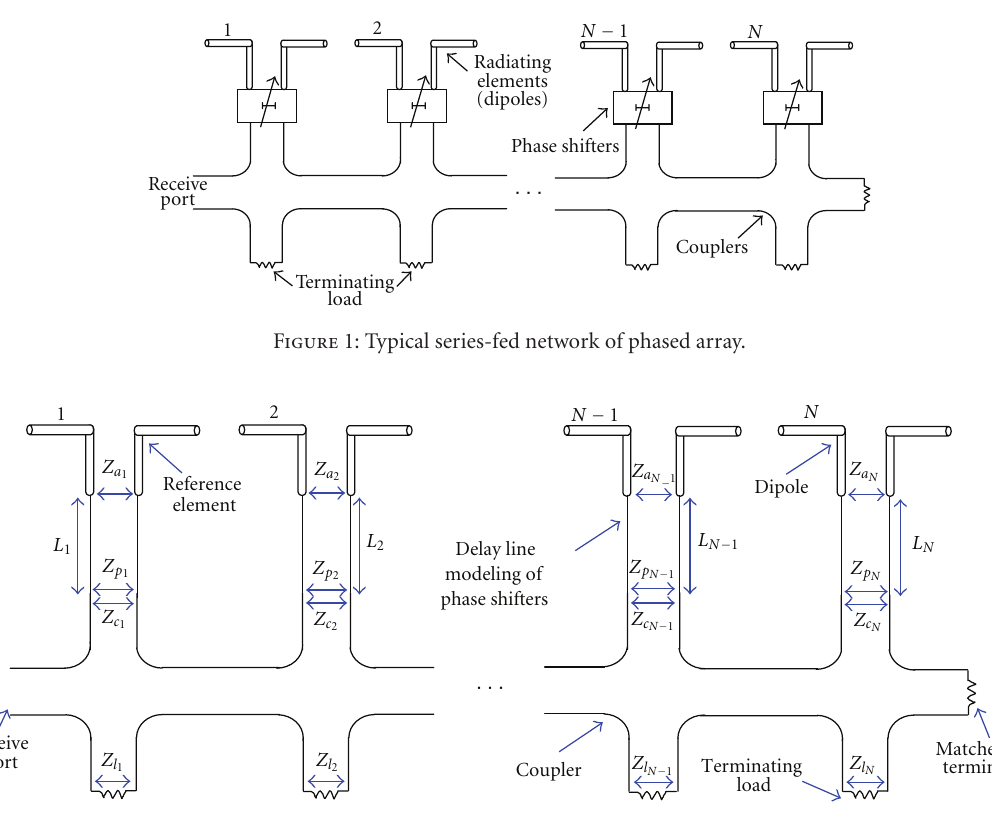
Figure 2: Impedances at di ff erent stages in a series-fed network.